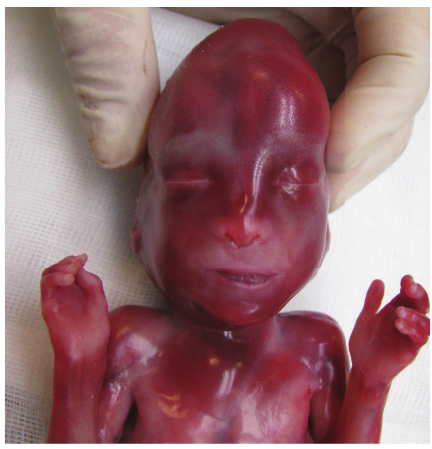
Figure 2: Anatomical postmortem exam of the fetus showing left diaphragmatic hernia with intrathoracic stomach, spleen, bowel, and liver.